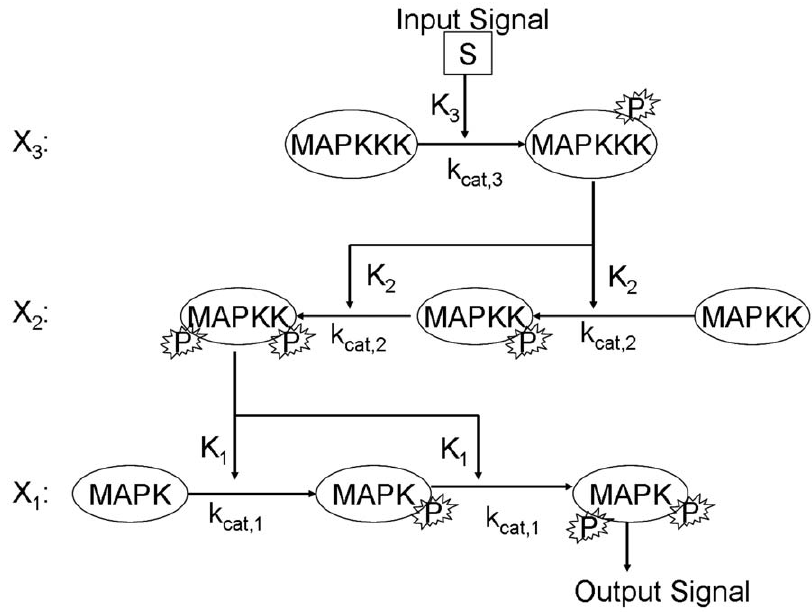
Figure 1. Cartoon representation of the canonical MAPK signaling pathway.